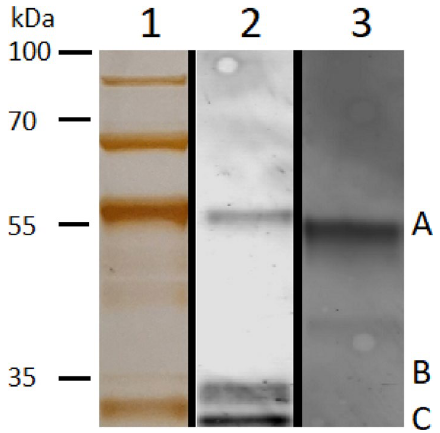
Figure 4. SDS-PAGE and western blot analysis of purified His-GST-METTL7B-D98A: (Lane 1) SDS-PAGE silver stain of a representative gel showing purified His-GST-METTL7B-D98A (A) (4.2 µg total protein) (Lane 2) Anti-GST antibody western blot of purified His-GST-METTL7B-D98A (3 µg total protein). (Lane 3) Anti- METTL7B antibody western blot of purified His-GST-METTL7B-D98A (4.3 µg total protein). Molecular weight markers are shown to the left. Upper bands, above 55 kDa, are co-purifying chaperone proteins as determined by proteomic analysis (data not shown). Lower molecular bands, marked by letters B and C, are fusion protein fragments containing the dual His-GST affinity